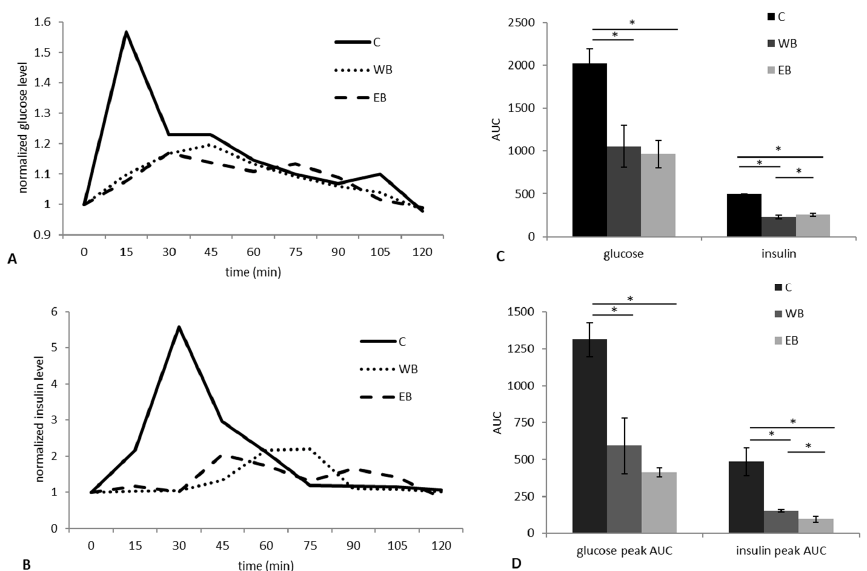
Figure 1. Postprandial glucose and insulin responses after einkorn (EB) or wheat (WB) bread consumption in the pig model (n = 4). ( A ) Glucose and ( B ) insulin trend waves among diets (fold of increase with respect to time 0). Area under the curve (AUC) for the entire curve ( C ) and for the first peak ( D ), in the three groups (EB, 50 g of einkorn bread; WB, 50 g of wheat bread; C (control), 50 g of glucose as a reference food). * for p value < 0 . 05, Kruskal–Wallis test.